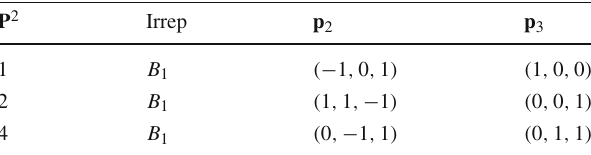
Table 8 Possible two-pion individual momenta in the B 1 irrep for dif- ferent values of P 2 of the two-pion